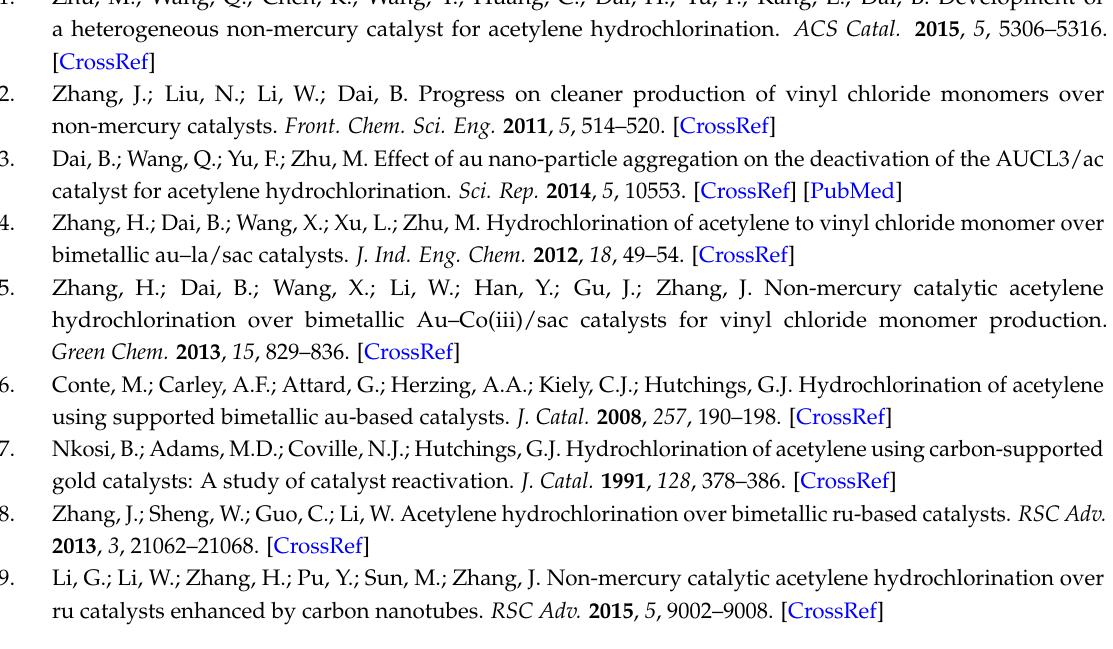
Figure S1: The N 2 adsorption-desorption isotherms for (a) fresh and (b) spend catalysts, Figure S2: Representative TEM figures of (a) used-Mo 2 N/AC; (b) used-TiN/AC and (c) used-Mo 3 Ti1N/AC, respectively, Figure S3: XPS spectra of Mo 2 N/AC, TiN/AC and Mo 3 Ti1N/AC, Figure S4: TG-DTG curves of six different catalysts: (a) Mo 2 N/AC; (b) TiN/AC; (c) Mo 1 Ti1N/AC; (d) Mo 2 Ti1N/AC; (e) Mo 3 Ti1N/AC and (f) Mo 4 Ti1N/AC, Table S1: N contents in catalysts analysis by EA, Table S2: Metal elements content in samples investigate by